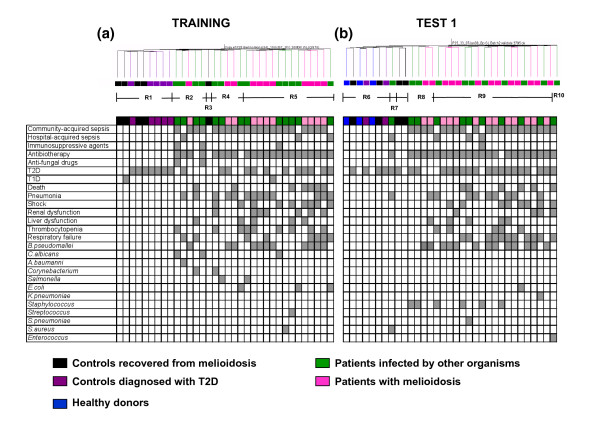
Comparison of phenotypic and clinical information with unsupervised condition clustering. The distribution of subjects who were defined as community-acquired or nosocomial septicemia, given antibiotics before blood collection (Antibiotherapy), diagnosed with T1D or T2D, organ dysfunction, pneumonia, and microbial diagnosis is indicated on a grid aligned against the hierarchical condition tree generated through unsupervised clustering (Figure 2) for both (a) training and (b) test set 1.